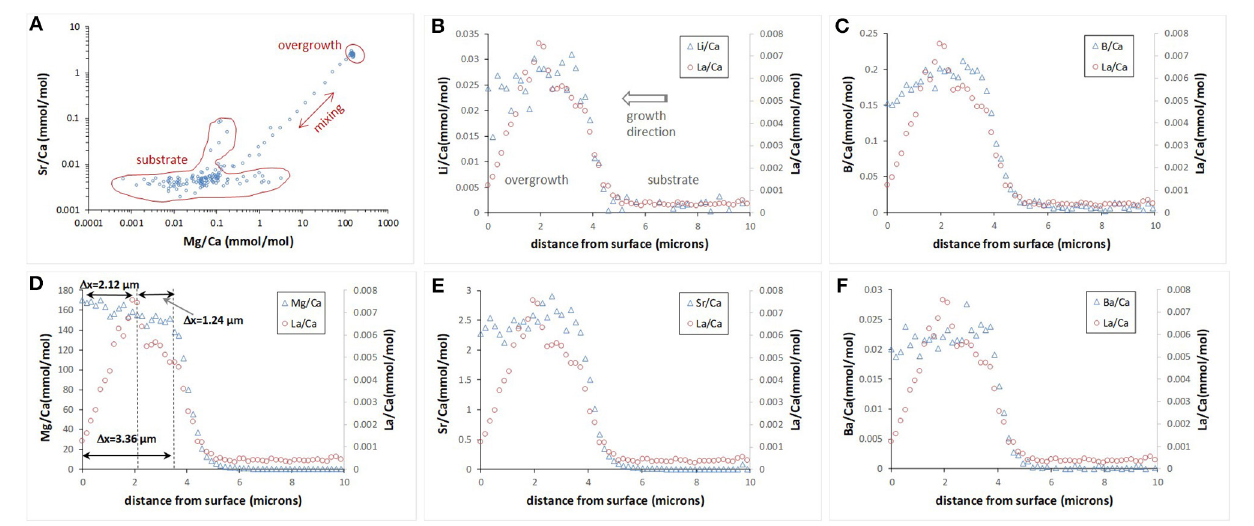
FIGURE 3 | Example of E/Ca depth profile evaluated by LA-ICP-MS. Sr/Ca vs. Mg/Ca collected in the 163 depth steps (0–29 µ m) show distinct chemical composition of the calcite substrate, new formed calcite overgrowth, and mixing zone (A) . E/Ca profiles for the top 10 µ m (B–F) ; zero distance is an outer edge of the overgrowth.